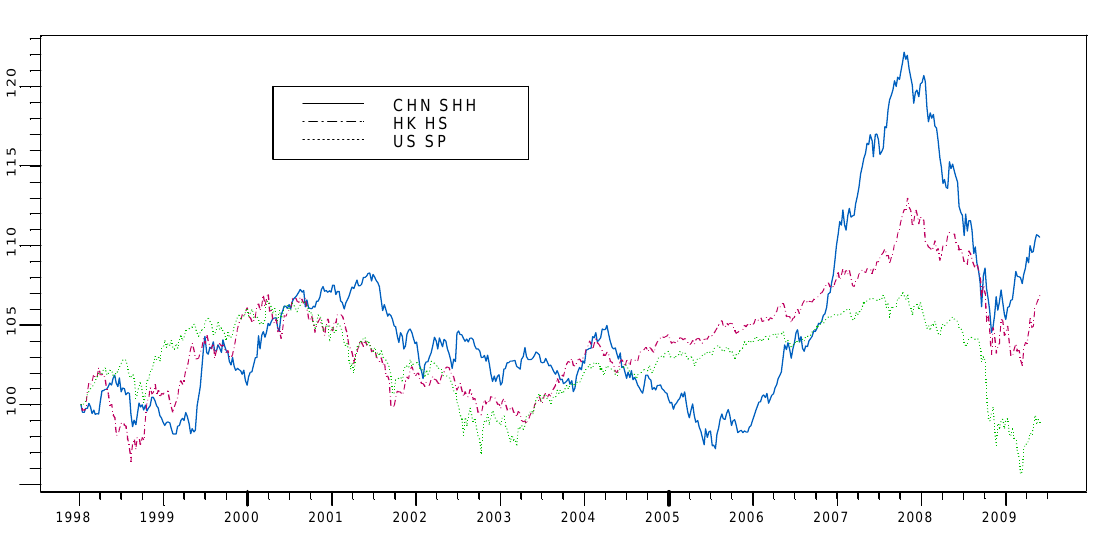
Figure 1: Stock indices of China, USA and Hong Kong